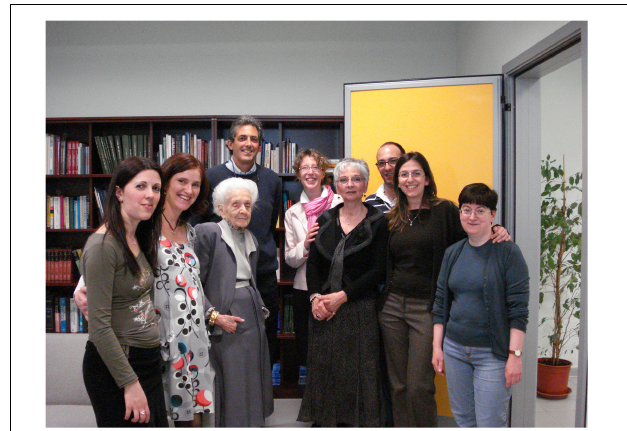
FIGURE 6 | Rita Levi-Montalcini with EBRI researchers after a Christmas party. From left to right: Annalisa Manca, Raffaella Scardigli, Antonino Cattaneo, Francesca Paoletti, Anna Di Luzio, Domenico Vignone, Francesca Malerba, and Simona Capsoni (from EBRI Media